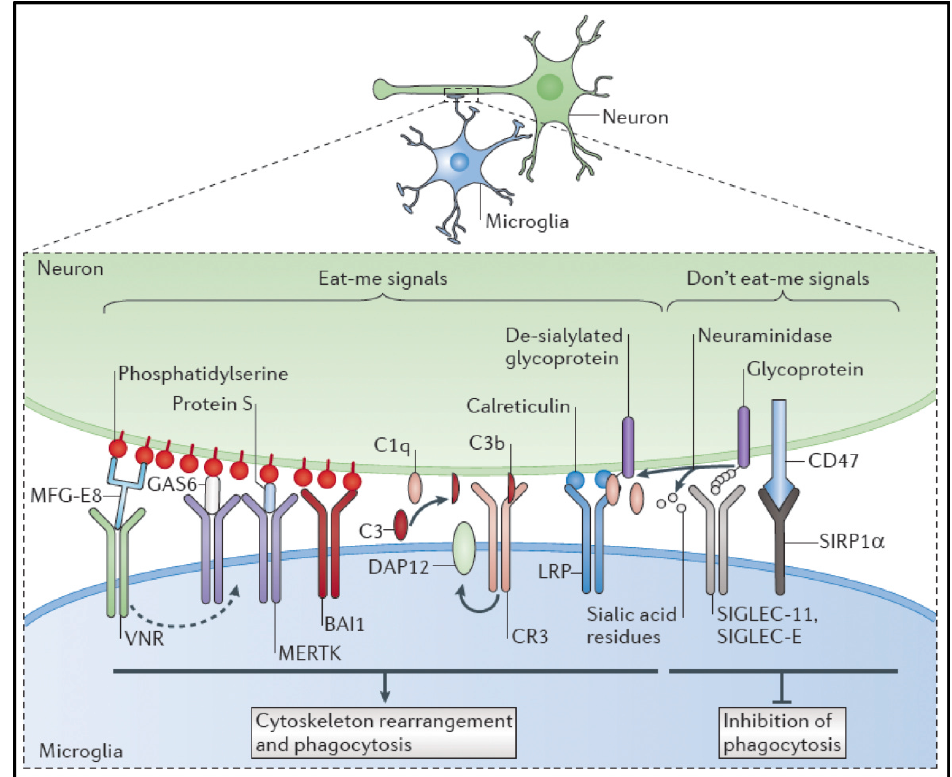
Figure 1. Signalling pathways implicated in the phagocytosis of neurons and neuronal structures. Microglial phagocytosis of neurons is regulated by the neuronal presentation and microglial recognition of ‘eat-me’ (left) and ‘don‘t eat-me’ (right) signals. [Figure and legend reproduced with permission from: Brown GC & Neher JJ. Microglial phagocytosis of live neurons . Nat Rev Neurosci 2014 4